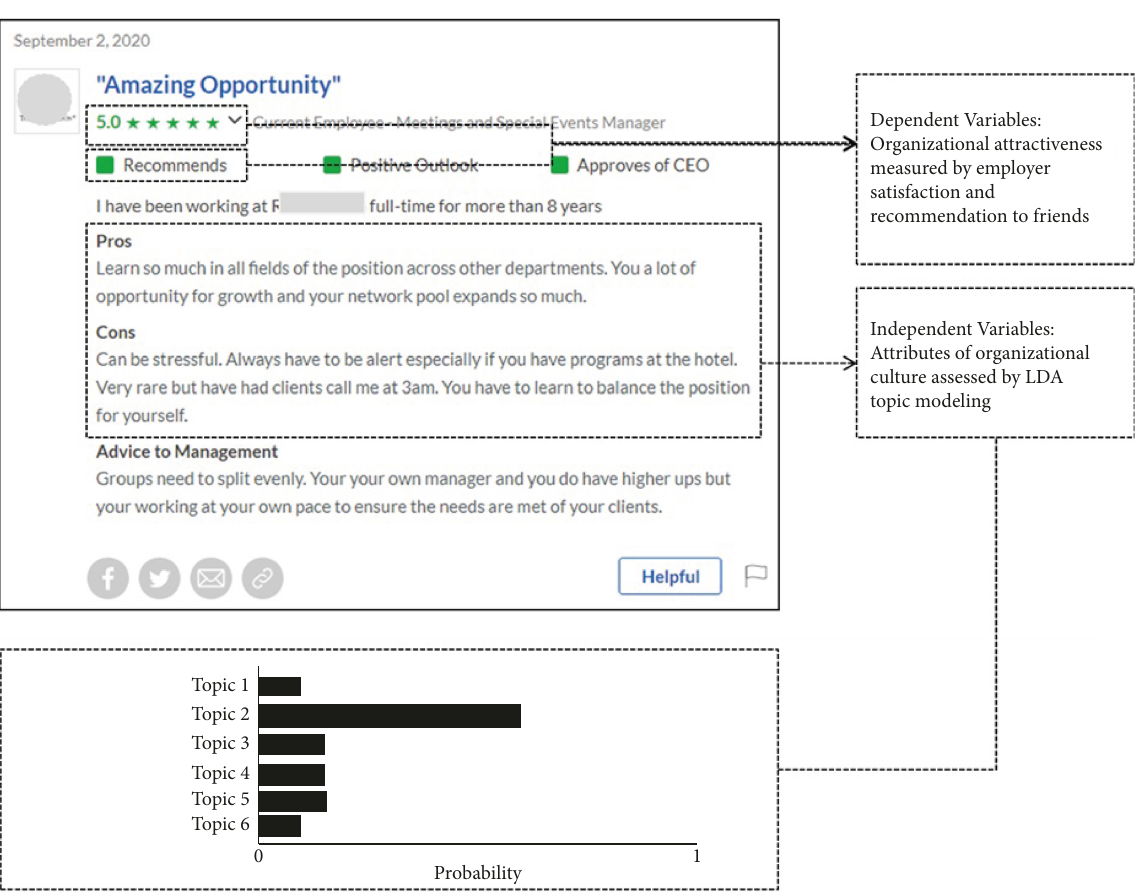
Figure 1: Example of employee review in Glassdoor and conceptualization of